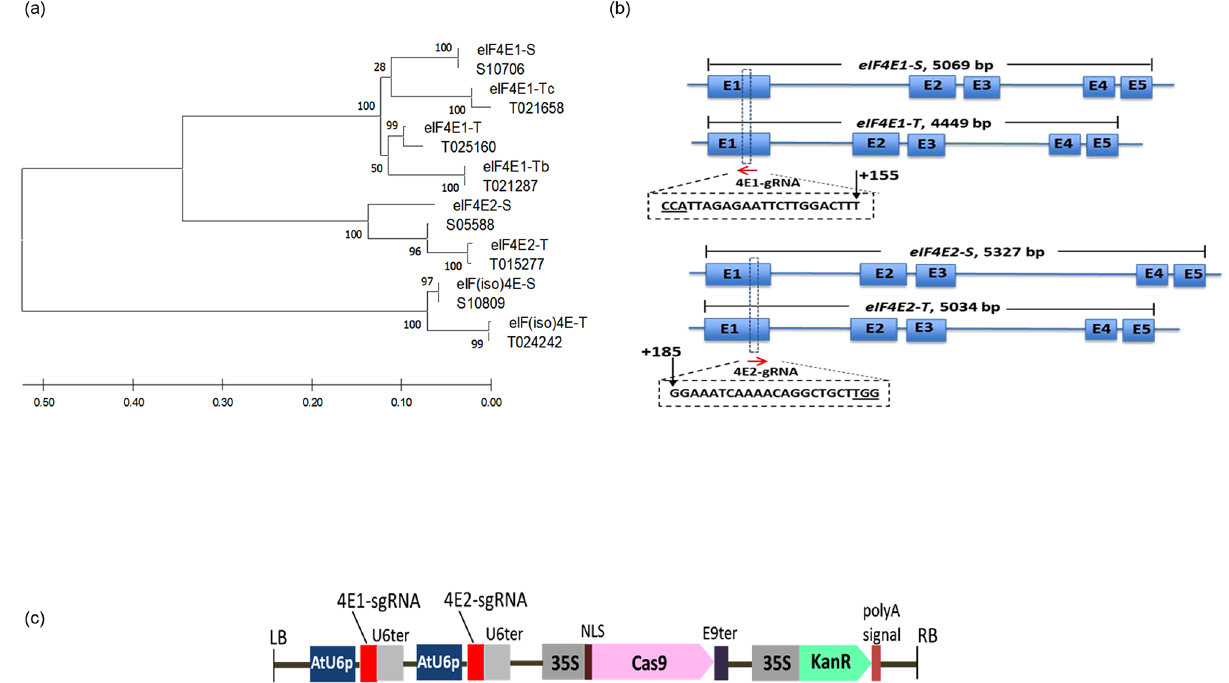
Figure 1. Tobacco eIF4E diversity, sgRNAs selection and CRISPR/Cas9 vector map. ( a ) Phylogenetic analysis of the eIF4E family in tobacco cultivar K326. The phylogenetic tree was constructed by the maximum likelihood method using the nucleotide alignment of genes encoding eukaryotic initiation factors in tobacco variety K326 along with reference sequences including the N. tomentosiformis (T) genome [T015277 (Genbank KM202067), T021658 (Genbank KM202068), T021287 (Genbank KM202069), T025160 (Genbank KM202070) and T024242 (Genbank KM202065)]; the N. sylvestris (S) genome [S10760 (Genbank KF155696), S05588 (Genbank KM202071), and S10809 (Genbank KM202066)]; and the K326 eIF4E/eIF(iso)4E genes [ eIF4E1-S ; eIF4E1-T ; eIF4E1-Tc ; eIF4E1-Tb ; eIF4E2-T ; eIF4E2-S , eIF(iso)4E-S ; eIF(iso)4E-T ]. Bootstrap values are shown above the corresponding branches. ( b ) Schematic of the eIF4E gene structures and the CRISPR/Cas9 target sites. The position and sequence of sgRNA target sites are indicated by a red arrow and a dashed rectangle, respectively. The sequences of the protospacer adjacent motifs (PAM) are underlined. The position of the sgRNA targeted region relative to the translation start site of the corresponding ORF is indicated by a black arrow. E1-E5, exons of eIF4E genes. ( c ) Schematic of the CRISPR/Cas9-sgRNA construct used for tobacco transformation. KanR Kanamycin resistant gene, Cas9 Maize-codon-optimized Cas9 gene driven by the 35S promoter (Cauliflower Mosaic Virus promoter); two sgRNAs (4E1-sgRNA and 4E2-sgRNA) regulated by the Arabidopsis U6 promoter (AtU6p), U6ter Arabidopsis U6 terminator, E9ter Pea RuBisCO small subunit E9 terminator, NLS Nuclear localization signal, LB/RB left and right eF-7 had mutations in both paralogs (T and S) of eIF4E1 and eIF4E2 , respectively. Importantly, eF-10 and eF-31 showed induced mutations at all four tested eIF4E genes by heteroduplex analysis (Fig. 2).